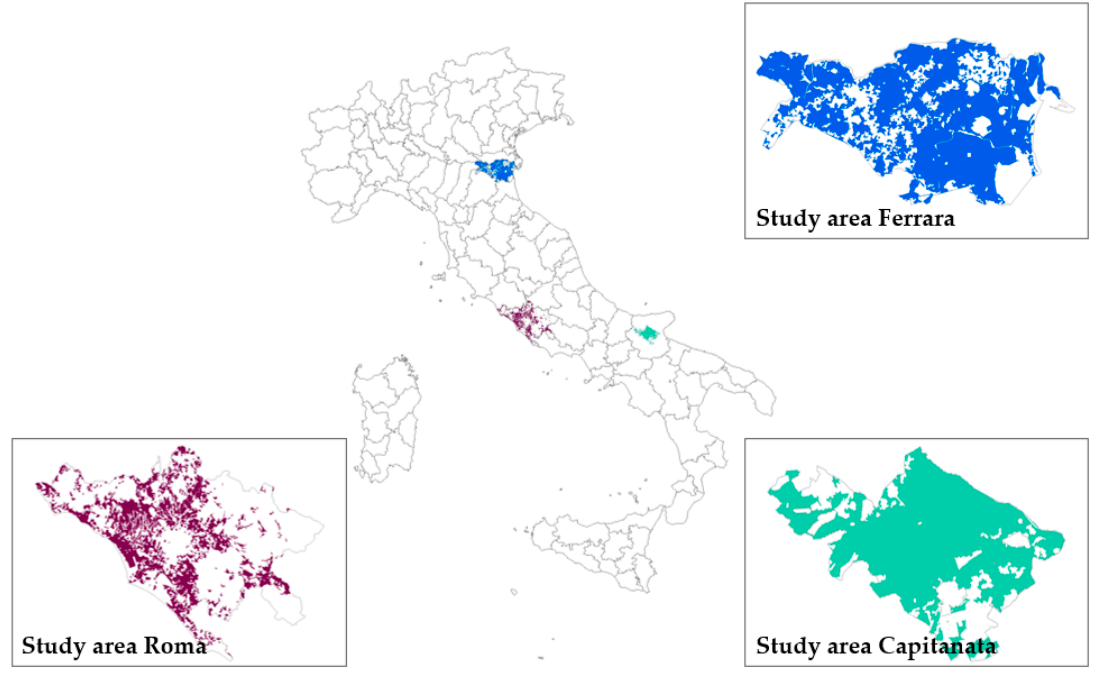
Figure 1. Study areas: (Ferrara: Northern Italy, Rome: Central Italy and Capitanata: Southern Italy). The agricultural arable land areas in the experimental localities are presented in colors.